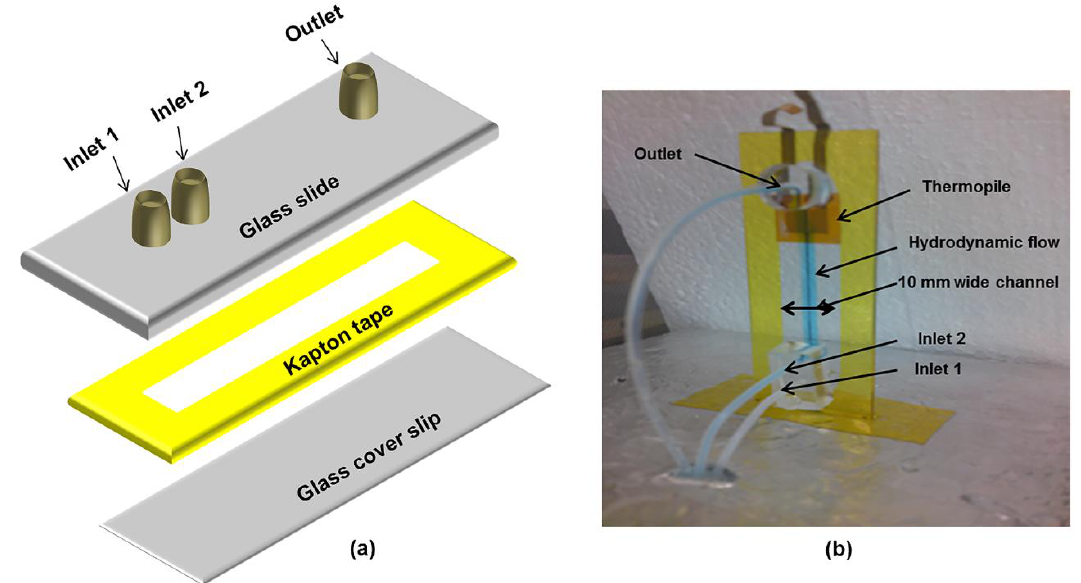
Figure 2. Thermoelectric microfluidic L-glutamate sensor. ( a ) Schematic showing microfluidic device fabrication. ( b ) Microfluidic device showing hydrodynamic flow and thermopile attached on the lower channel wall of the microfluidic device. The dimensions of the components are glass slide—75 × 25 × 1.2 mm, glass coverslip—75 × 25 × 0.17 mm, and channel—60 × 10 × 0.12 mm. Volume of the microfluidic channel is 72 µL.